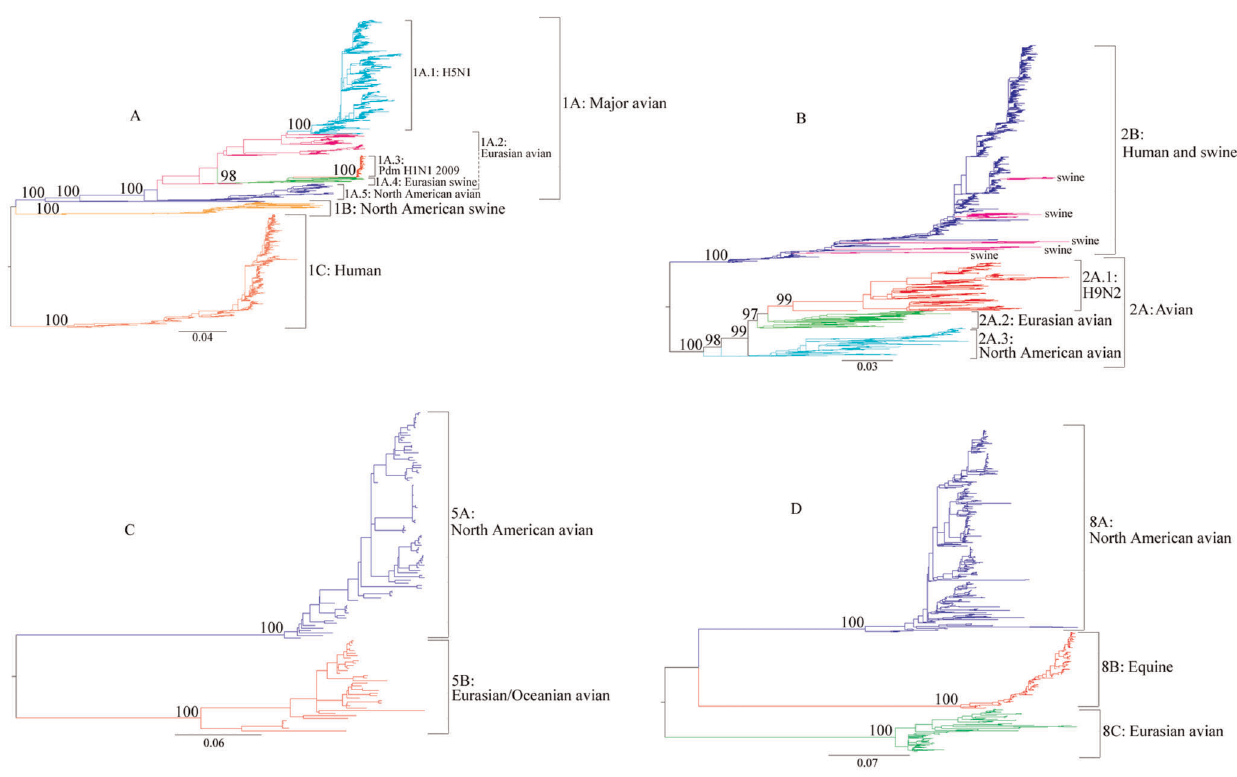
Figure 2. Maximum-likelihood (ML) tree of influenza A NA subtypes. A: N1; B: N2; C: N5; D: N8. The annotation for each lineage was labeled on the trees. Three lineages in N1 (1A, 1B and 1C), two lineages in N2 (2A and 2B), two lineages in N5 (5A and 5B), and two lineages in N8 (8A and 8B) were classified. The bootstrap values supporting the corresponding lineages are shown to the left of the major nodes. Scale bars indicate the numbers of nucleotide substitutions per